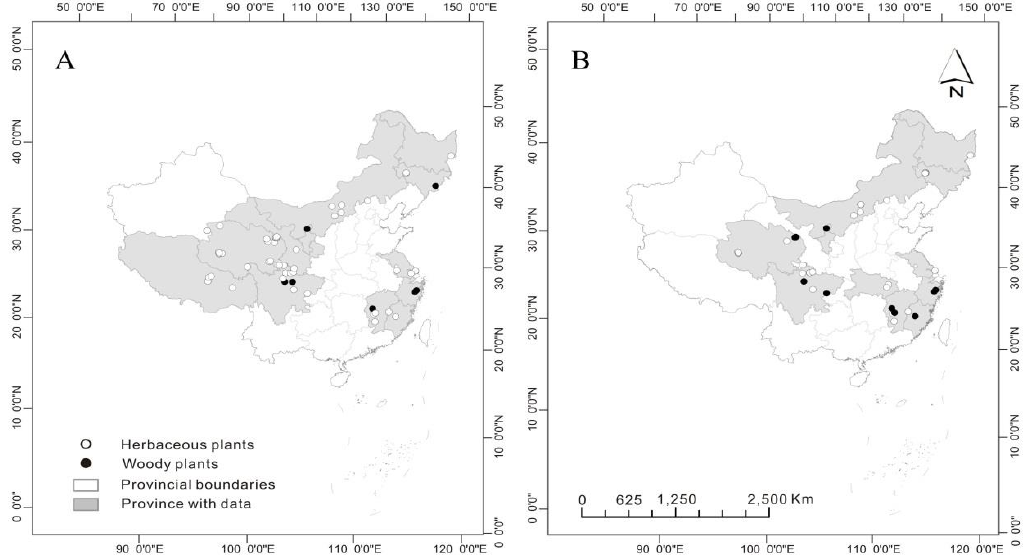
Figure 1. Study sites included in this meta-analysis across the whole of China: ( A ) Above-ground biomass, ( B ) Below-ground biomass. We grouped plant types by herbaceous plants (open circles) and woody plants (closed black circles). For detailed distribution information, please see the Supplementary Material (S6).